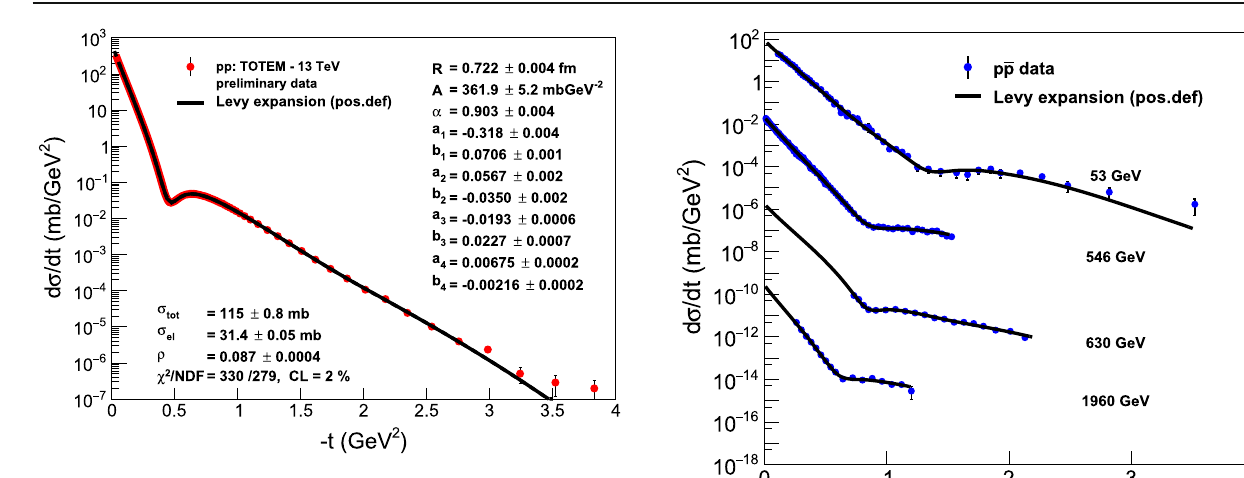
Fig. 3 Model-independent Lévy expansion results from fits to the TOTEM preliminary elastic pp scattering data at the currently largest √ s = 13 TeV. The errors on the fit parameters and the LHC energy of fit quality are also preliminary